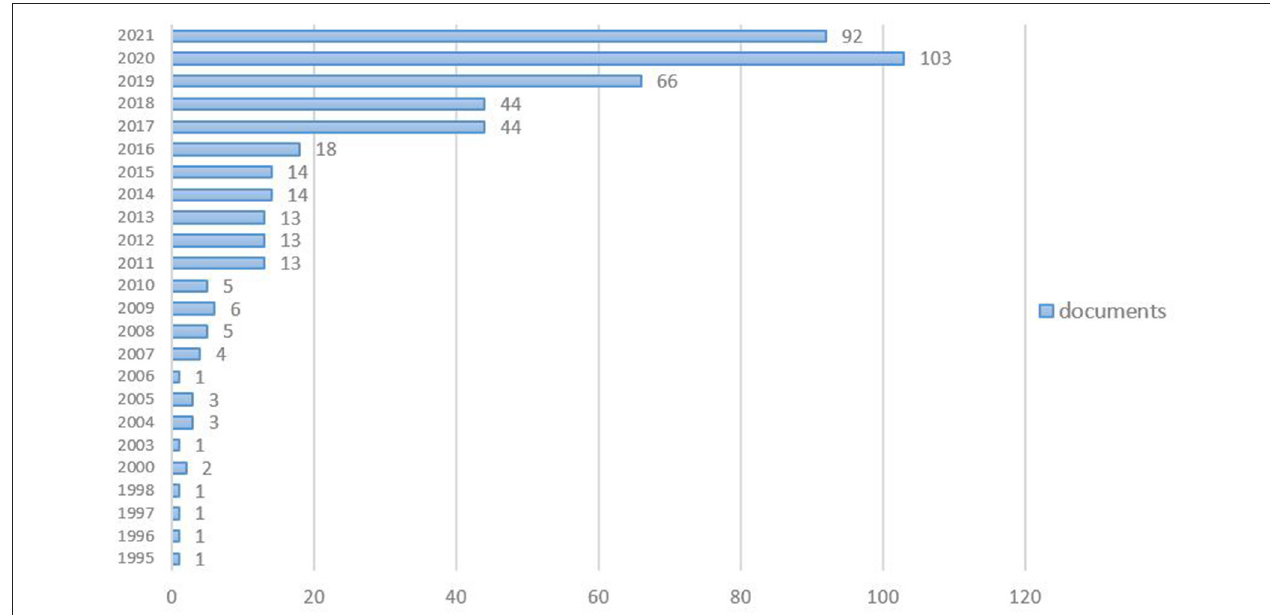
FIGURE 1 | Distribution of research quantity.